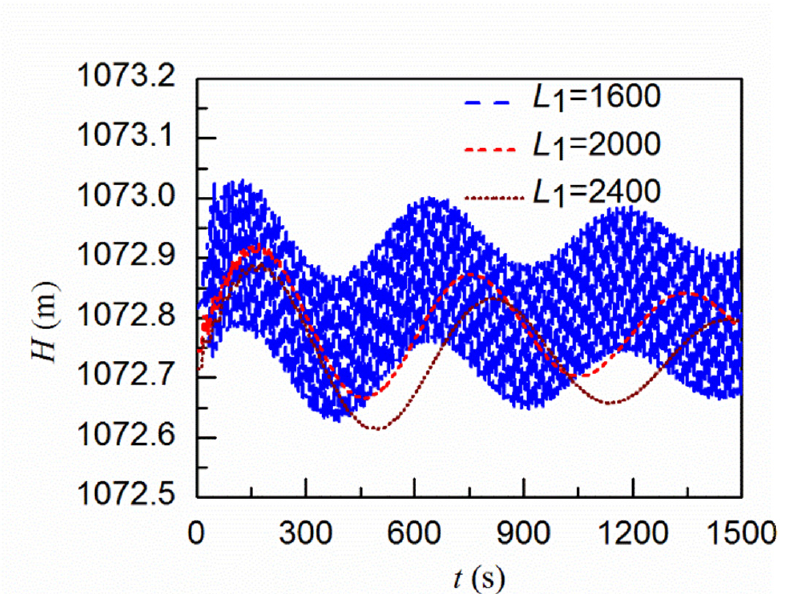
Figure 15. Comparison of the water level fluctuations in the sand basin with different locations of the sand basin ( h = 10 m, w = 10 m).